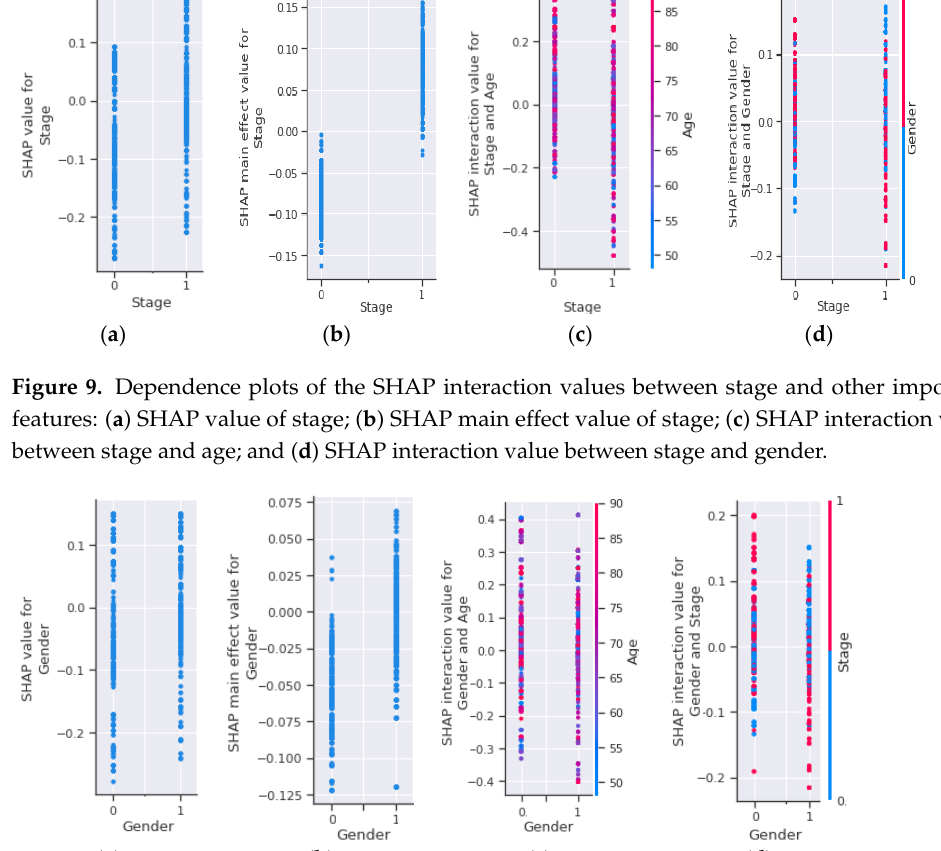
Figure 10. Dependence plots of the SHAP interaction values between gender and other important features: ( a ) SHAP value of gender; ( b ) SHAP main effect value of gender; ( c ) SHAP interaction value between gender and age; and ( d ) SHAP interaction value between gender and stage.